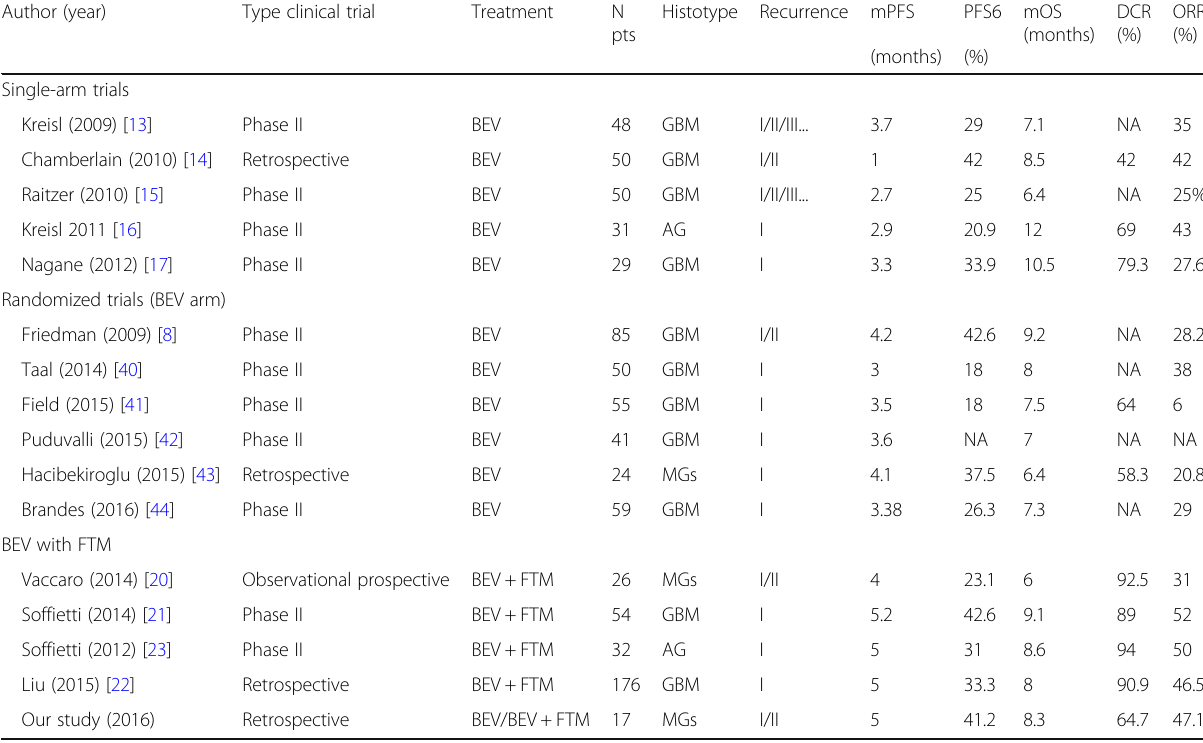
Table 4 Survival results of the main clinical trials evaluating Bevacizumab as single-agent or in combination with FTM Author